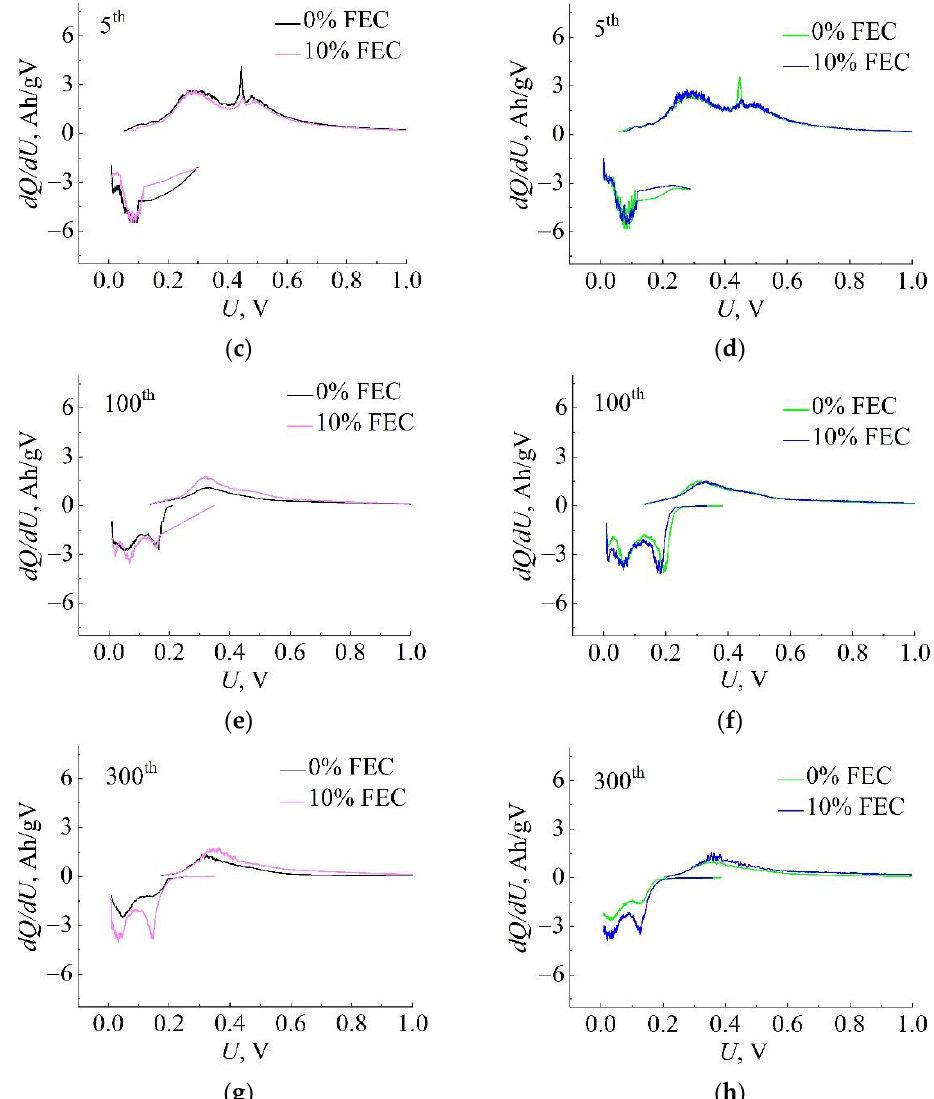
( B ) Figure 7. Charge – discharge curves at various rates of electrodes in pairs ( A , B ) after the 300th cycle. The impedance of all samples was measured in a charged (completely lithiated) state: the first measurement on the 3rd cycle, subsequent measurements every 15 cycles. After the current was switched off, the cells were kept for a sufficiently long time, during which a stationary potential U = 0.14 ± 0.01 V was established on them. Figure 8 shows the Nyquist plots for five selected cycles. Since the surface area of all samples is the same, only the resistance (not specific value) is given along the x – y axes. For the early cycles, the impedance in the high-frequency range of samples with FEC was greater than those with- out FEC addition, and became comparable for both type of samples in the high-frequency range after long cycling. It should be noted that after long cycling the corresponding sem- icircles became flatter, which some authors explain by the emerging inhomogeneity of the SEI [12].